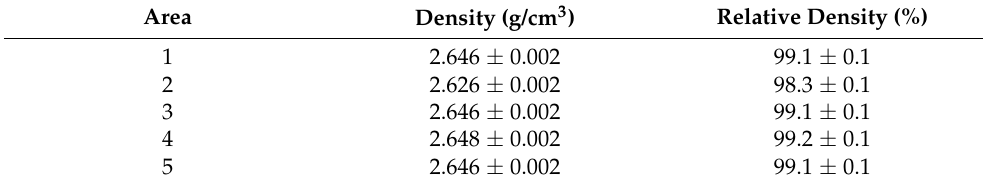
Table 2. Evolution of density and relative density as a function of production